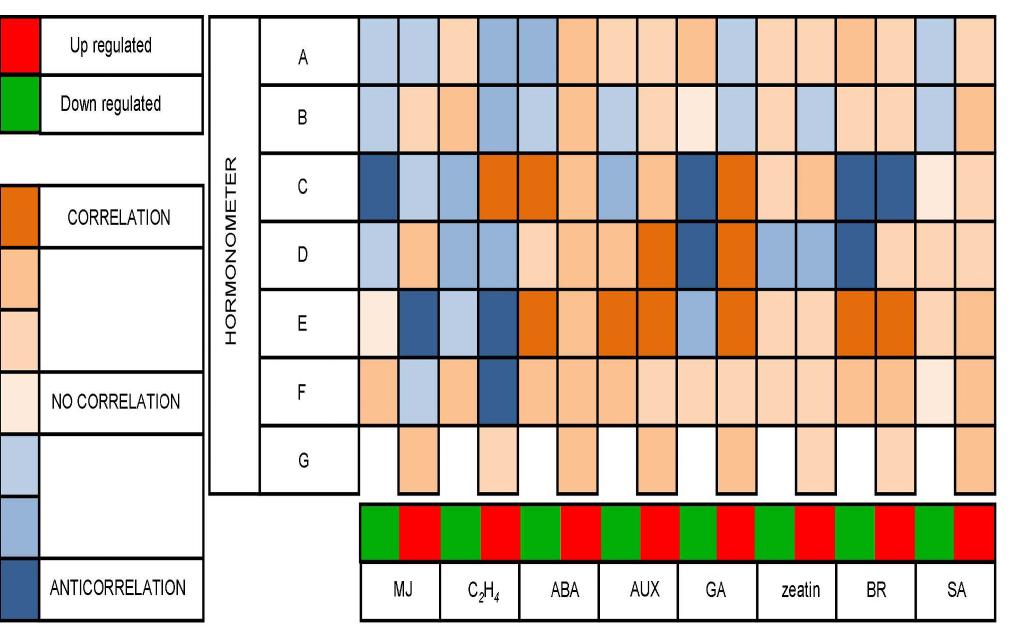
Figure 5. Heat map showing the relationship between rhizome related differentially expressed genes (DEGs) and hormone target genes. The heat map was produced by analyzing genes comprising rhizome related DEGs for methyl jasmonate (MJ), ethylene (C 2 H 4 ), abscisic acid (ABA), auxin (AUX), gibberellic acid (GA), zeatin, brassinosteroids (BR), and salicylic acid (SA). Subfigures a–g represent the seven gene sets analyzed: DEGs of RT vs. ST in O. longistaminata from (a) transcriptome sequencing and (c) microarray analysis, and (e) results of the present study in S. propinquum ; DEGs of underground tissues (RT and RI) vs. above-ground tissues (ST, SI, and YL) in O. longistaminata from (b) transcriptome sequencing and (d) microarray analysis, and (f) results of the present study in S. propinquum ; and (g) candidate rhizome-enriched genes in S. halepense (pSH) and S. propinquum . In the HORMONOMETER analysis, orange (1)=complete correlation, white (0)=no correlation, and blue (-1)=anti-correlation.